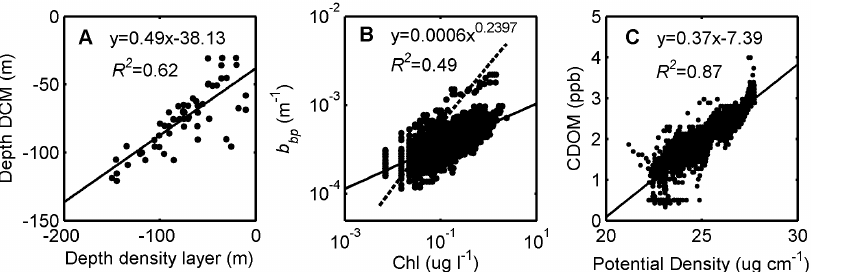
Figure 4. Bio-optical and bio-physical relationships determined based on float profile dataset. (A) depths of DCM vs. density layer r =1023.6, (B) Chl vs. b bp in the upper 200 m, and (C) CDOM vs. potential density over the entire water column. In panel B, comparison is shown to results from the algorithm of Morel and Maritorena ([23], dashed line) [2001]. The anomalously high b bp values correspond to the float profile from July 30 th , 2012, during which time a plume of terrigenous origin was advected offshore into the float’s path.